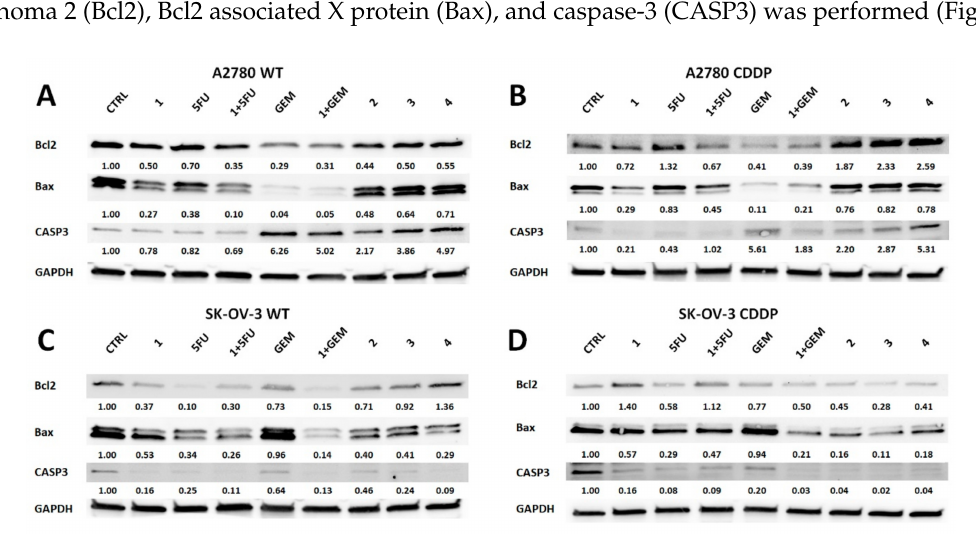
Figure 4. Western blot analysis of OvCa cell lines exposed to IC 50 values of selected compounds for 72 h ( A – D ). The expression of anti-apoptotic (Bcl2) and apoptotic proteins (Bax and CASP3) was